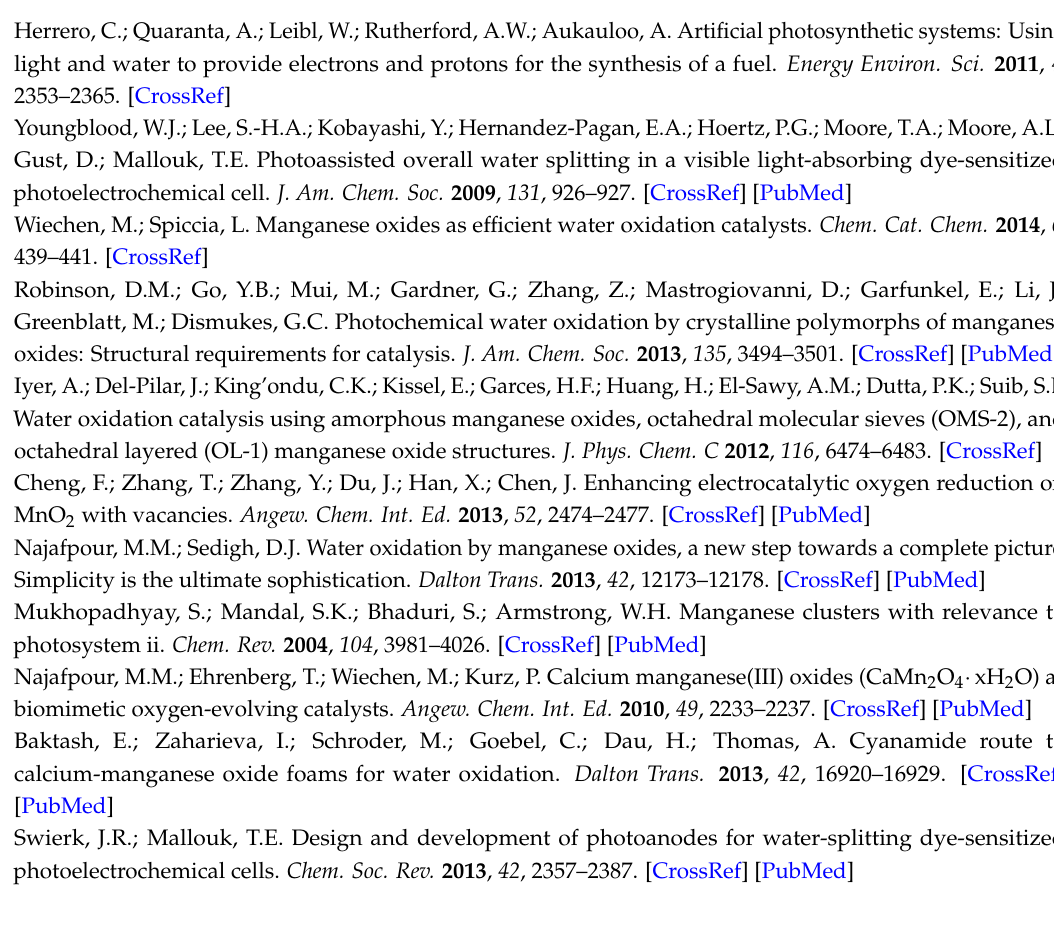
Figure S1: Cross-section FE-SEM image of a spin-coated film made with a non-ball-milled Mn 2 O 3 powder; Figure S2: FE-SEM cross-section images of the films prepared by spin-coating of MnO 2 (a); Mn 2 O 3 (b) and Mn 3 O 4 (c) powders; as-made electrodeposited 5-min film (d); Figure S3: UV-Vis transmittance spectra of the electrodeposited films: as-made (continuous line) and calcined at 500 ˝ C (dotted line); Figure S4: Photographs of the as-made films prepared by electrodeposition at different deposition times; and Figure S5: Nyquist plots of the EIS measurements acquired using the α -Mn 2 O 3 -based electrodes at 1.6, 1.8 and 2.0 V vs.